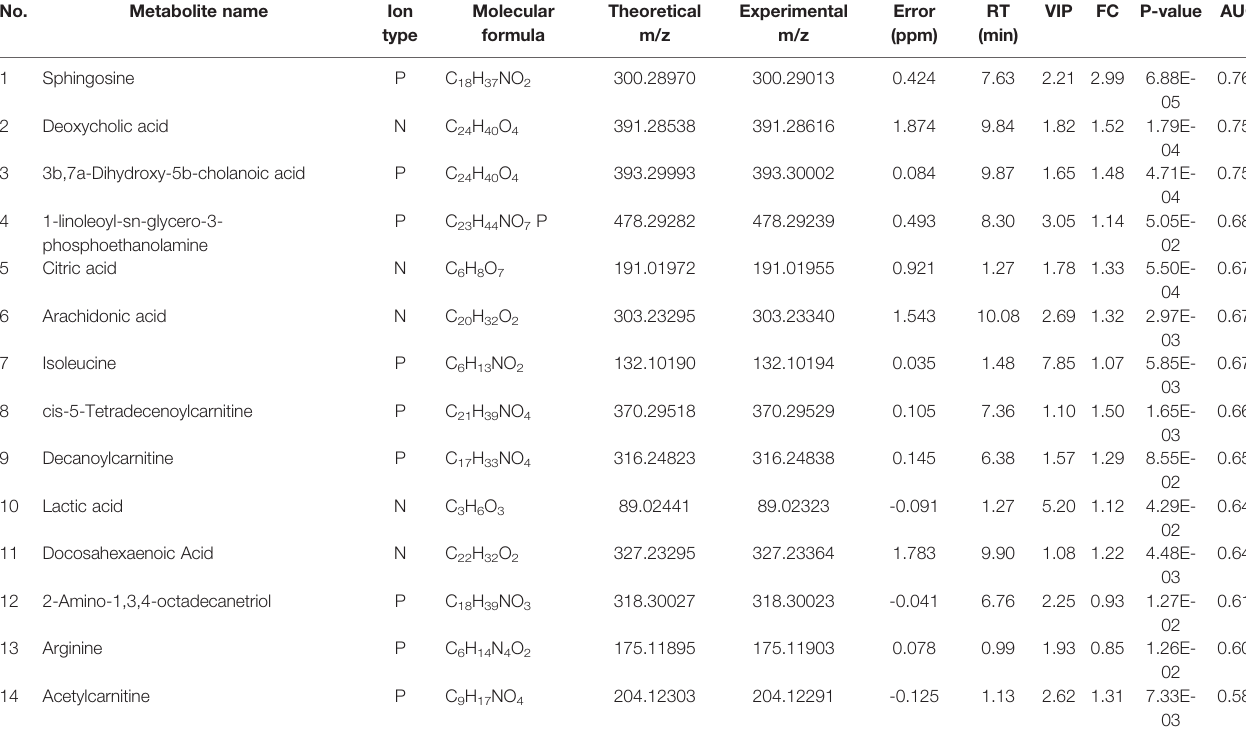
TABLE 4 | Differential metabolite identi fi cation results between EOLP group and ROLP group.